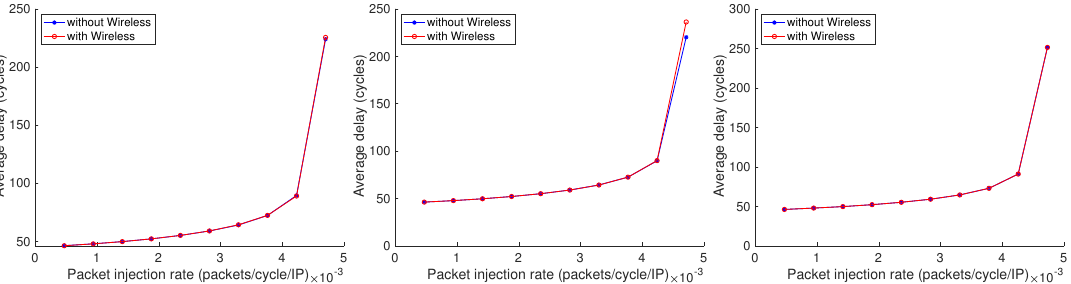
Figure 14. Average delay for profiles T 16 , T 32 , and T 64 for 1024 Mesh topology and random traffic (TR-1024 Mesh).